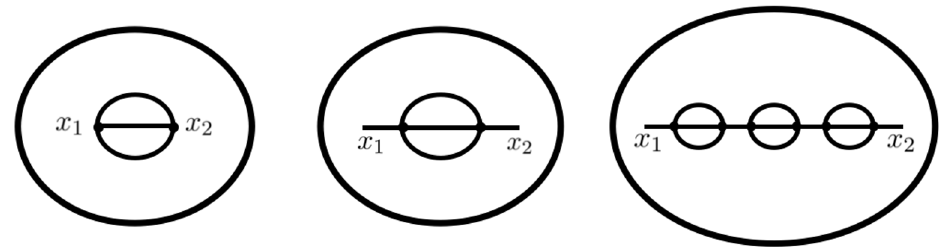
Figure 9 . Sunset diagrams. Left: the sunset bubble. Middle: φ 4 theory bulk 2-point function h φφ i bulk at 2-loops. Right: chain of sunset bubble diagrams in φ 4